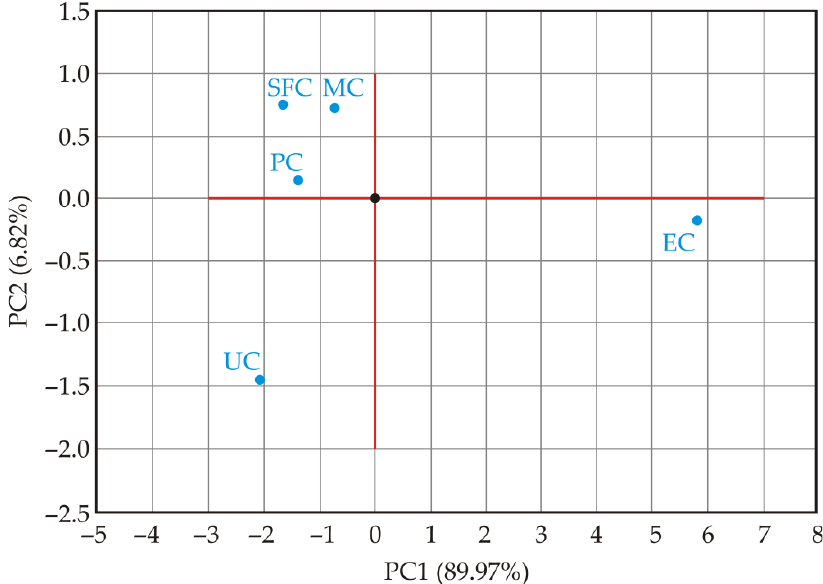
Figure 5. Principal component score plot of unprocessed and heat-treated corn (UC—unprocessed corn; PC—pelleted corn; SFC-steam-flaked corn; MC—micronized corn; EC—extruded corn).